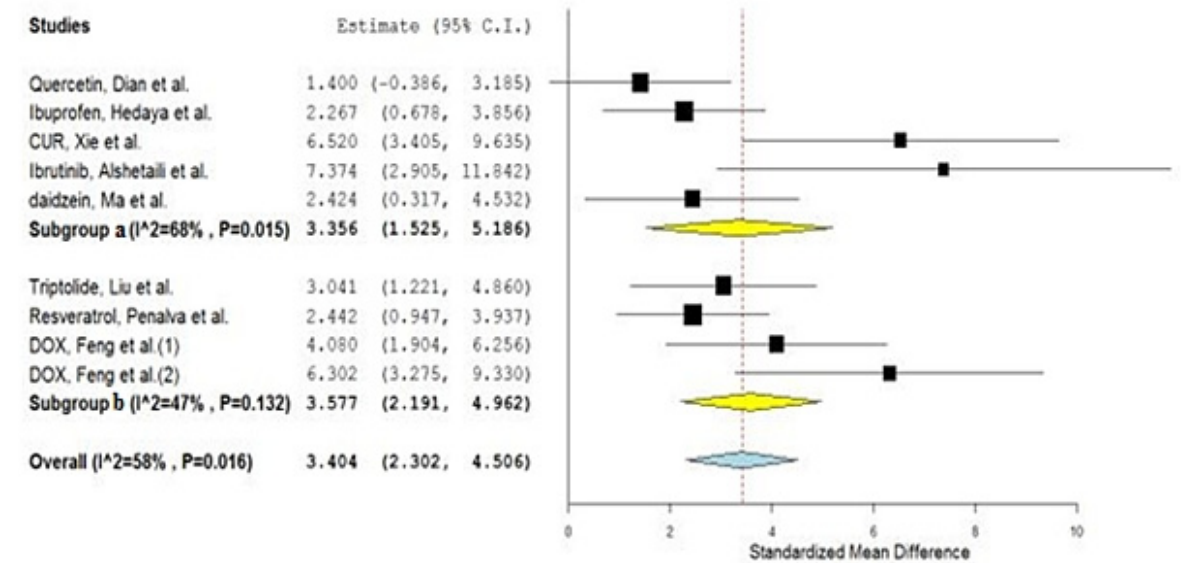
Figure 4. Forest plot of the investigated sub-groups: (a) synthetic polymeric nanoparticles, versus (b) natural polymeric nanoparticles.